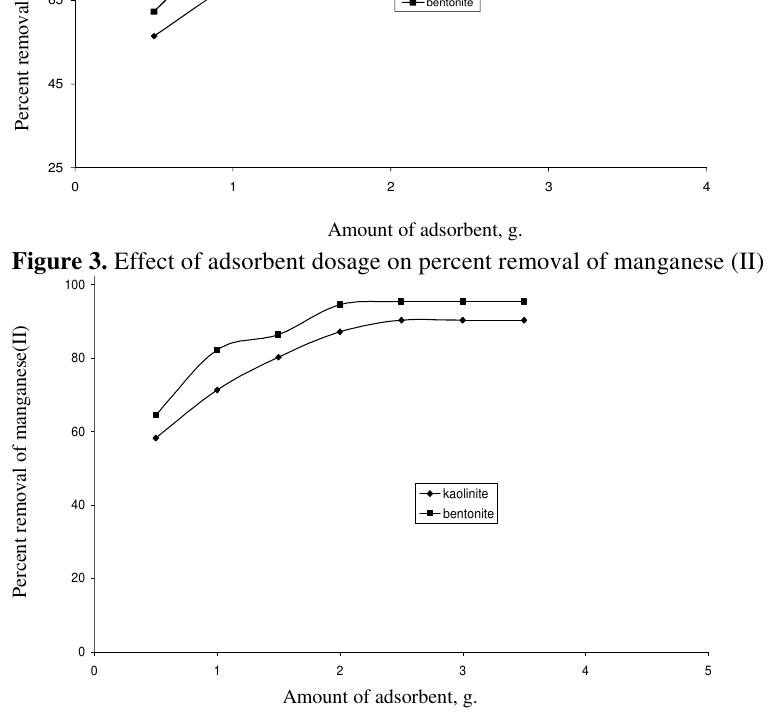
Amount of adsorbent, Figure 4. Effect of adsorbent dose on percent removal of manganese(II)